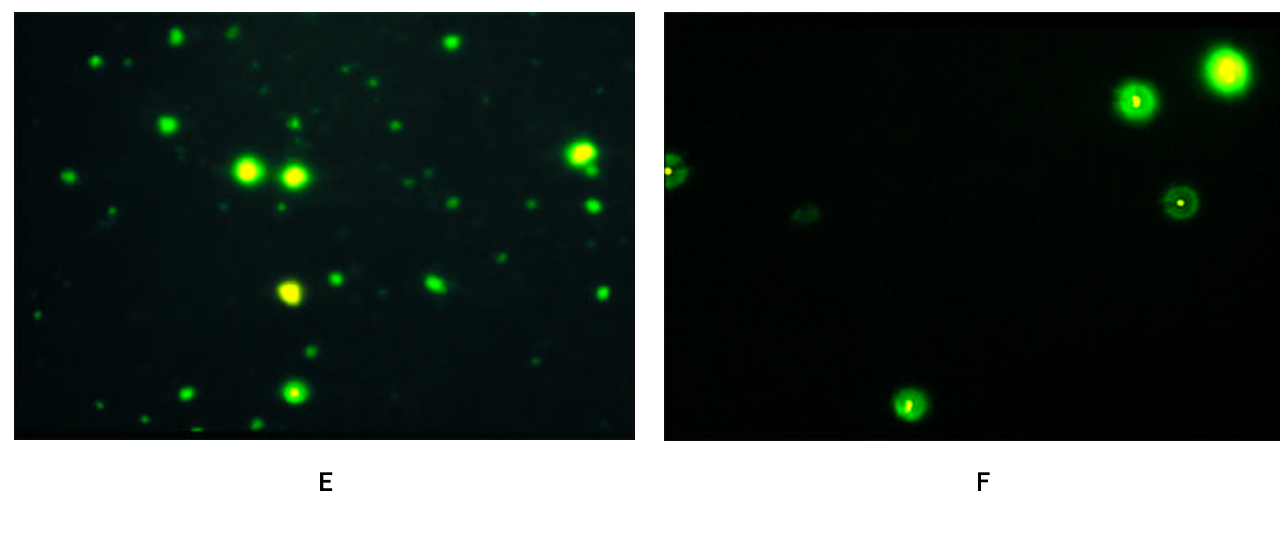
Binding of the antibody Y BHK cells (Y